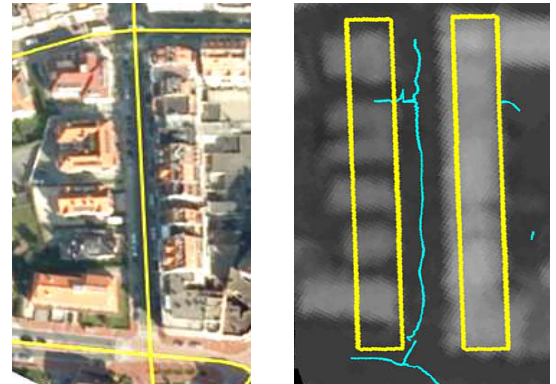
Figure 2: Left: RGB image with database roads. Right: nDSM with 3D-line extraction result (cyan) and region mask for computing entropy